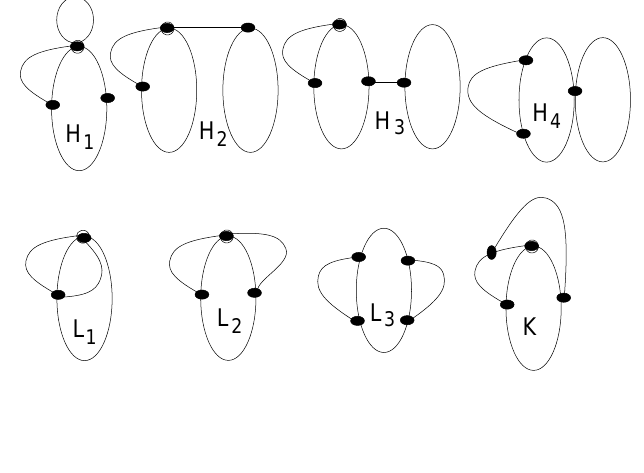
Figure 2: Tricyclic graphs with four cycles ( H 1 , H 2 H 3 and H 4 ), six cycles ( L 1 , L 2 and L 3 ) and seven cycles ( K ).